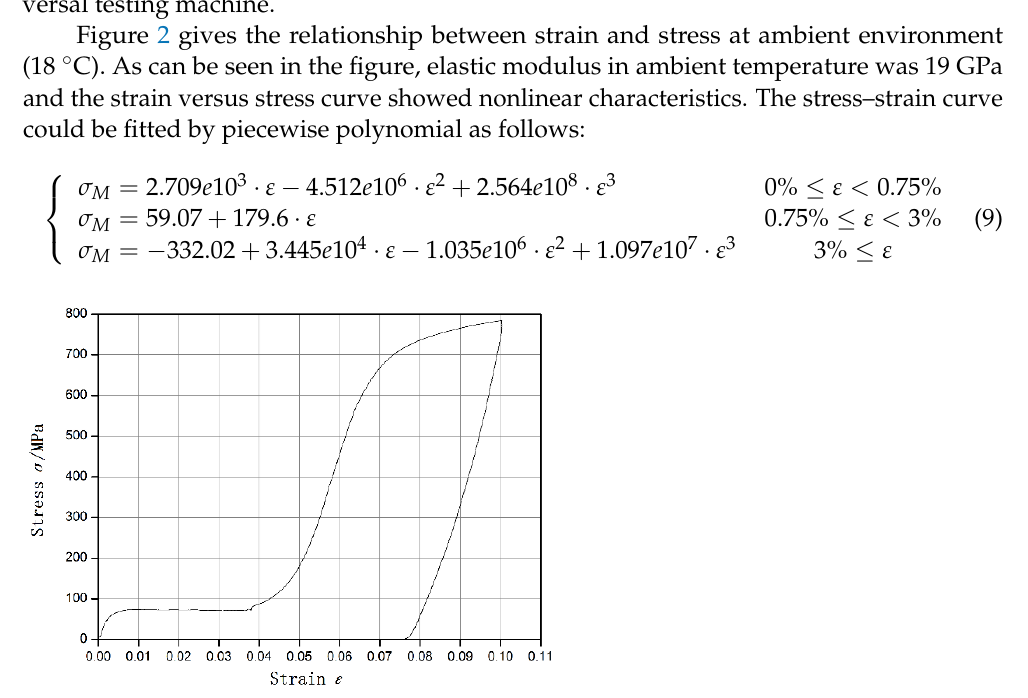
Figure 3. Strain versus stress curves of SMA at high temperature (56 °C). The driving displacement of SMA actuator should be large enough. It was necessary to measure the maximum recovery strain of SMA wires. The process was as follows. Four SMA wires were chosen as the test samples, and then they were soaked in ice water and boiling water repeatedly to make their performance stable. The SMA wires were stretched to 5.8%, 7%, 8%, and 9%, respectively. The deformation of SMA wires was measured by a large deformation measuring instrument, with the gauge distance of 100 mm and tensile speed of 0.7% per minute. After unloading, four samples with different pre-strain were obtained. The upper end of the wires was installed on the fixture of the drawing machine and the lower end was kept free. The free recovery curve of SMA wire was measured by the large deformation measuring instrument after the wires were electric heated. As can be seen from Figure 4, when the pre-strain exceeded 7%, the twin martensitic reorientation and stress-induced martensitic transformation of SMA had been completed and the stage of parent phase sliding would happen. During the stage of alma mater, strain would be irrecoverable. The results show that, when the pre-strain exceeds 5.5%, the recovery strain remains unchanged. That is, the maximum recoverable strain is 5.5%.